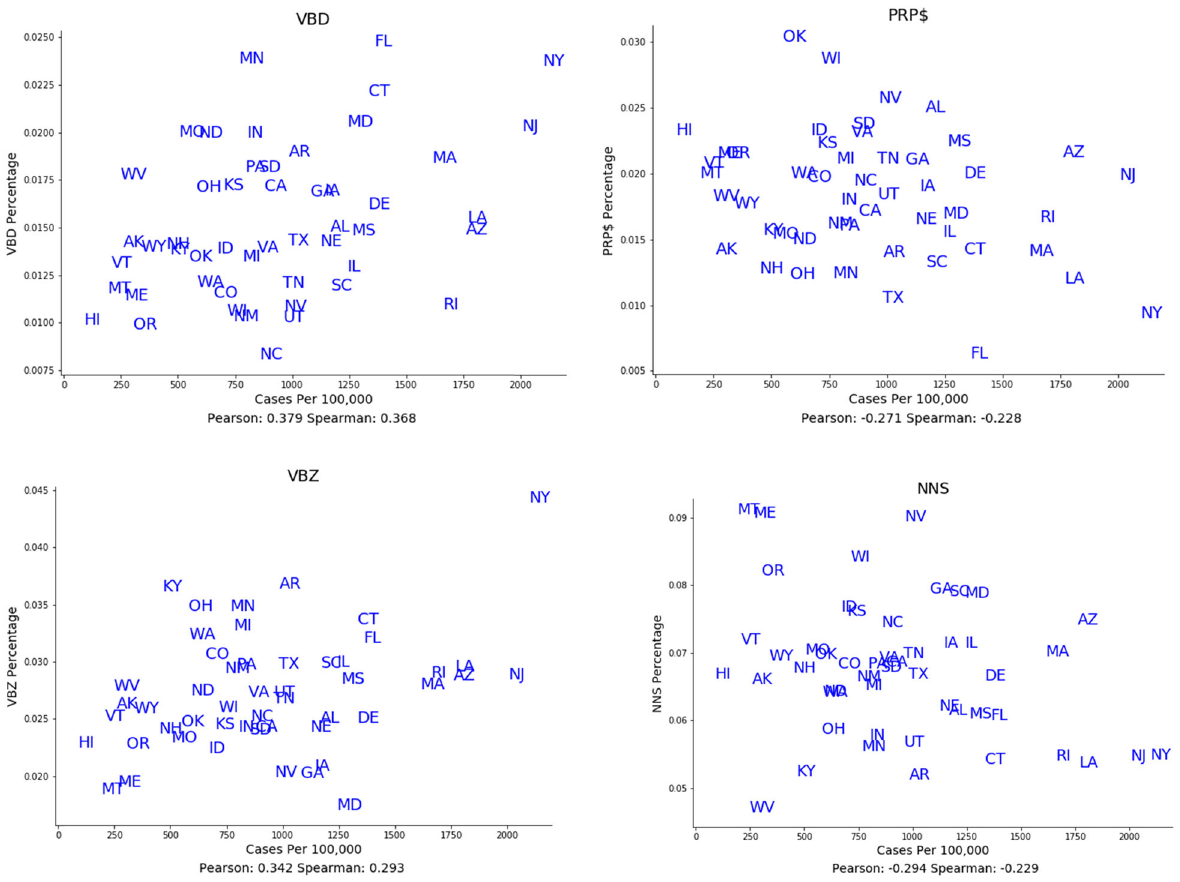
Fig. 5 Spatial associations of parts of speech with COVID-19 case rates. Both positive and negative associations are shown. States are represented by standard two-letter abbreviations. (VBD: Verb, past tense; VBZ: Verb, present tense; PRP$: Pronoun, possessive; NNS: Noun, common,